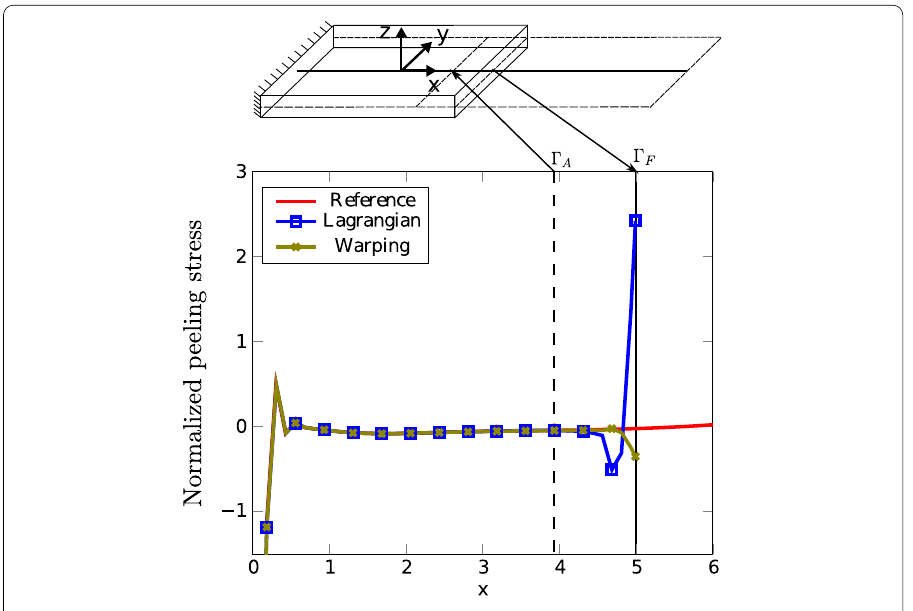
Fig. 9 Plate/3D coupling: use of overlap to avoid edge